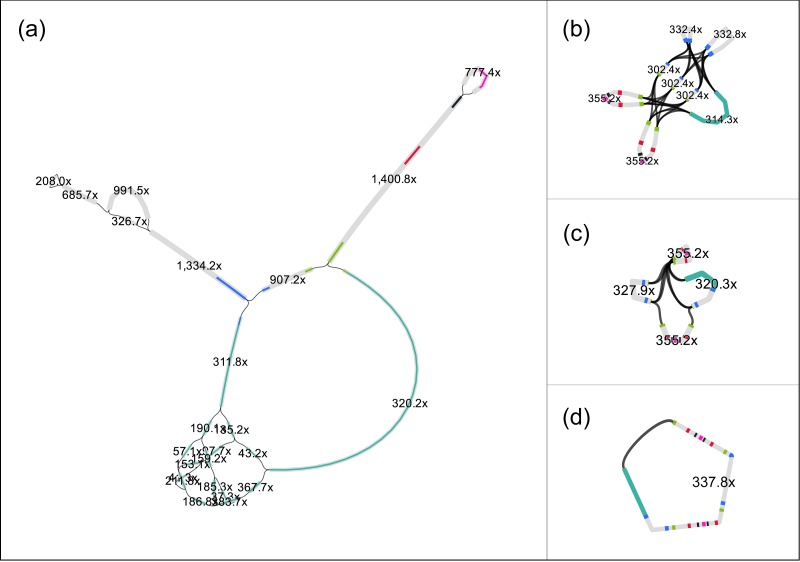
The original assembly graph of the fosmid data as delivered by SPAdes (A) and the simplifications obtained by RGFATools (B, C, D).The figure was prepared using Bandage (Wick et al., 2015).